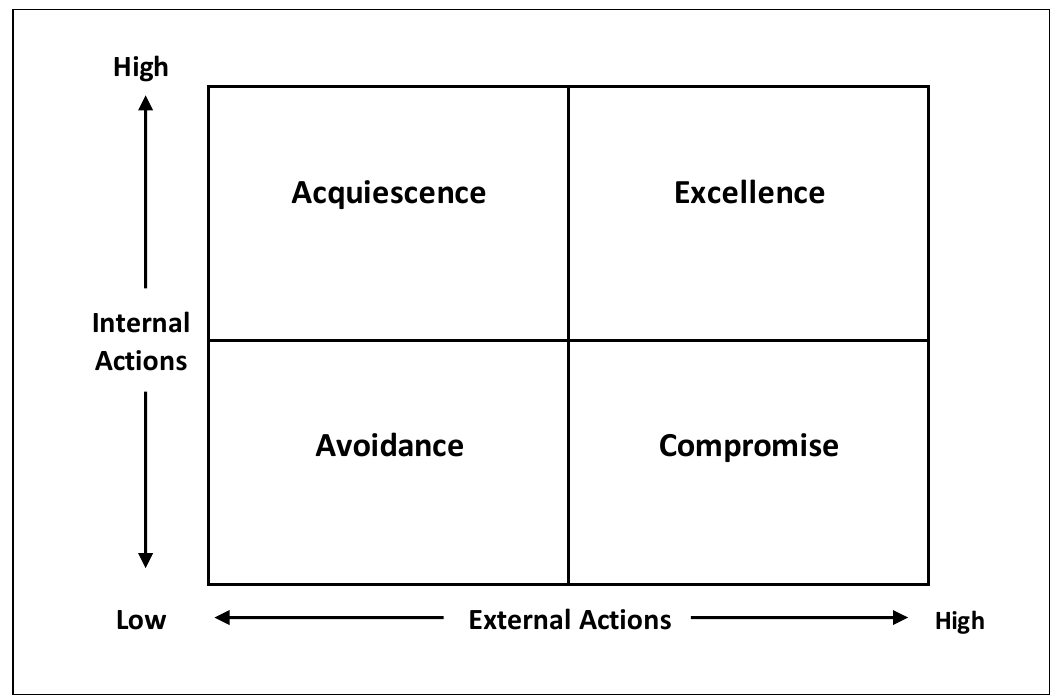
Figure 1. Carbon disclosure responses.